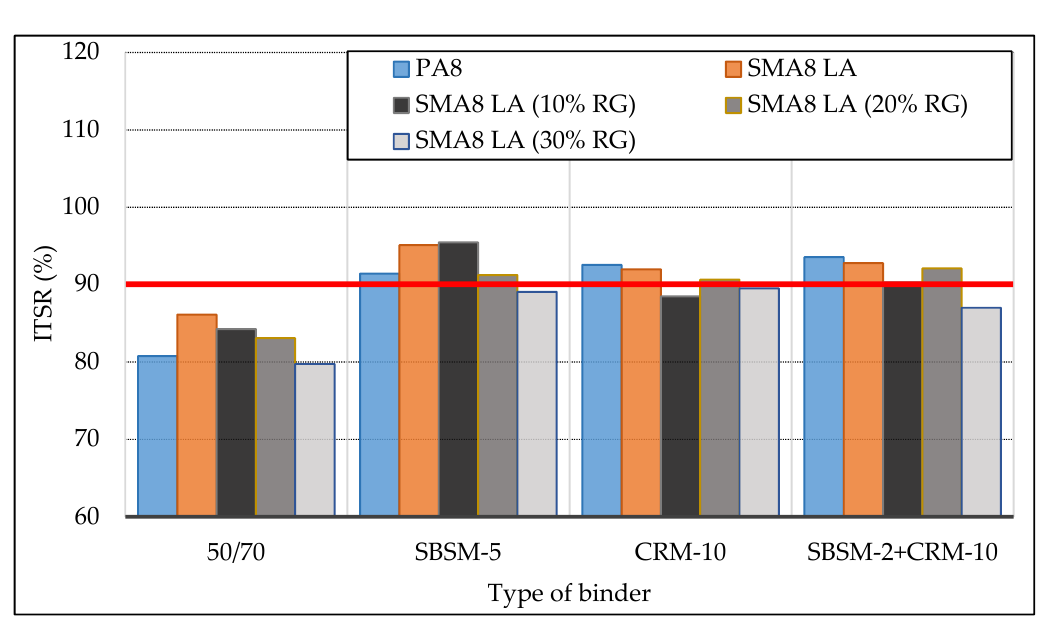
Figure 3. Water damage resistance ITSR.